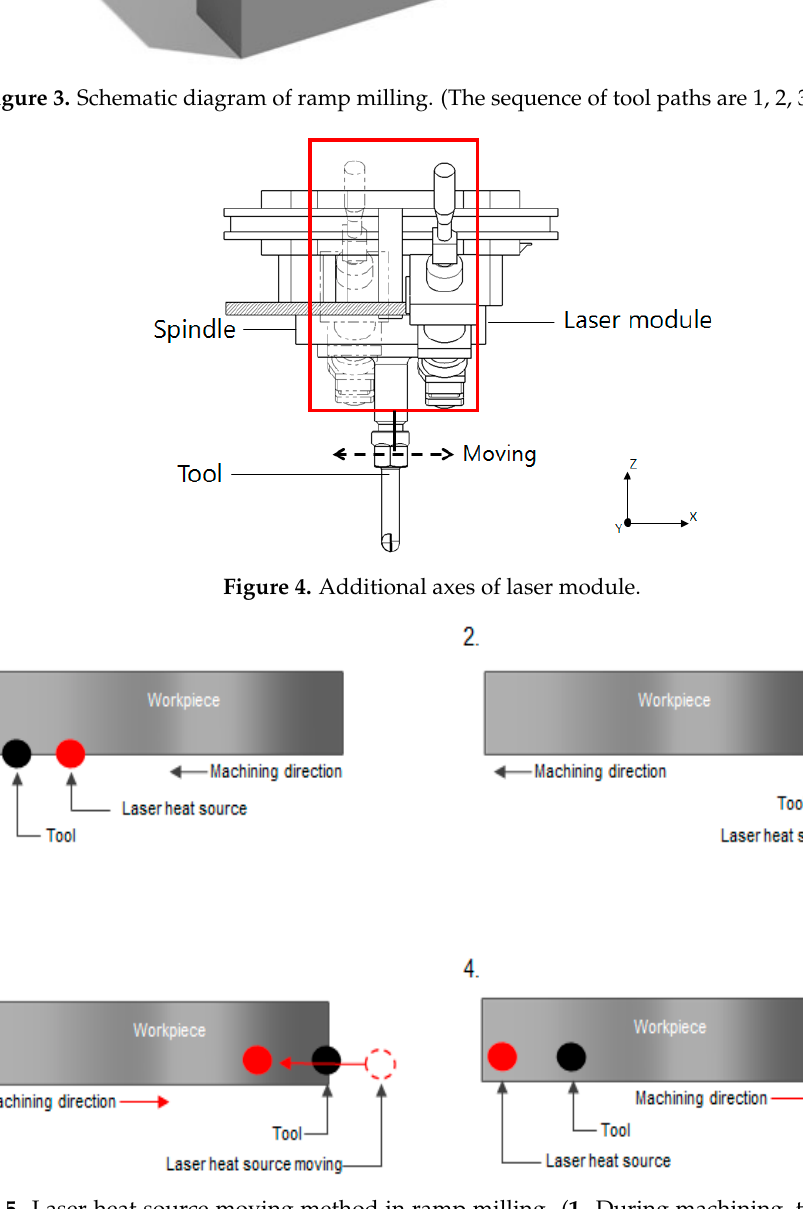
Figure 5. Laser heat source moving method in ramp milling. ( 1 . During machining, the laser heat source is located in front of the tool, 2 . After machining, the laser heat source is located behind of the tool, 3 . During the machining direction is change, the laser heat source is moved using the additional axis of the laser module (U-axis moving), 4 . During machining, the laser heat source is located in front of